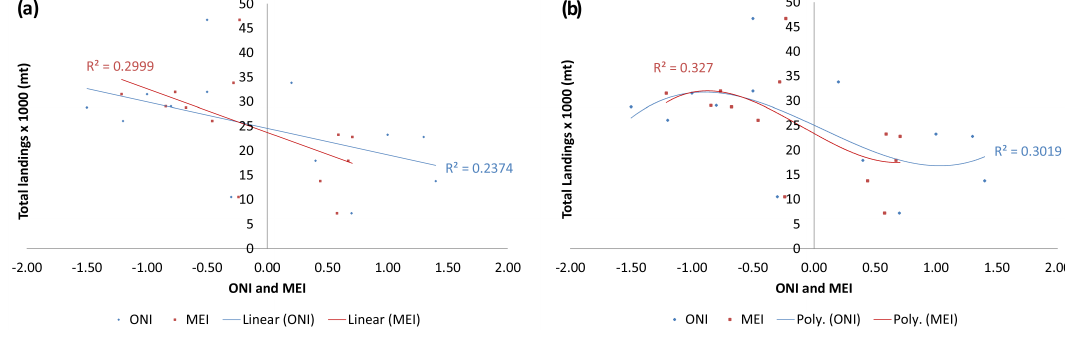
Figure 4. Total landings in Q 4 vs. the ONI and MEI (2000–2012). Polynomial regression, n =